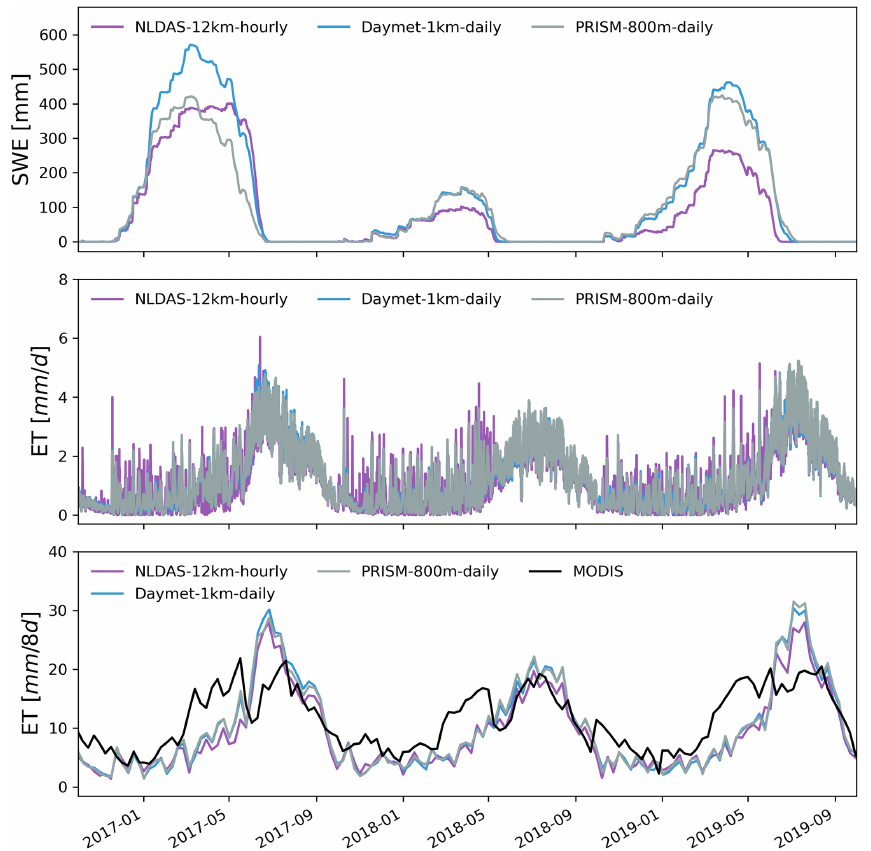
Figure 7. Simulated hourly watershed average SWE and ET under different meteorological forcings. Also shown is the comparison between MODIS and simulated 8d composite